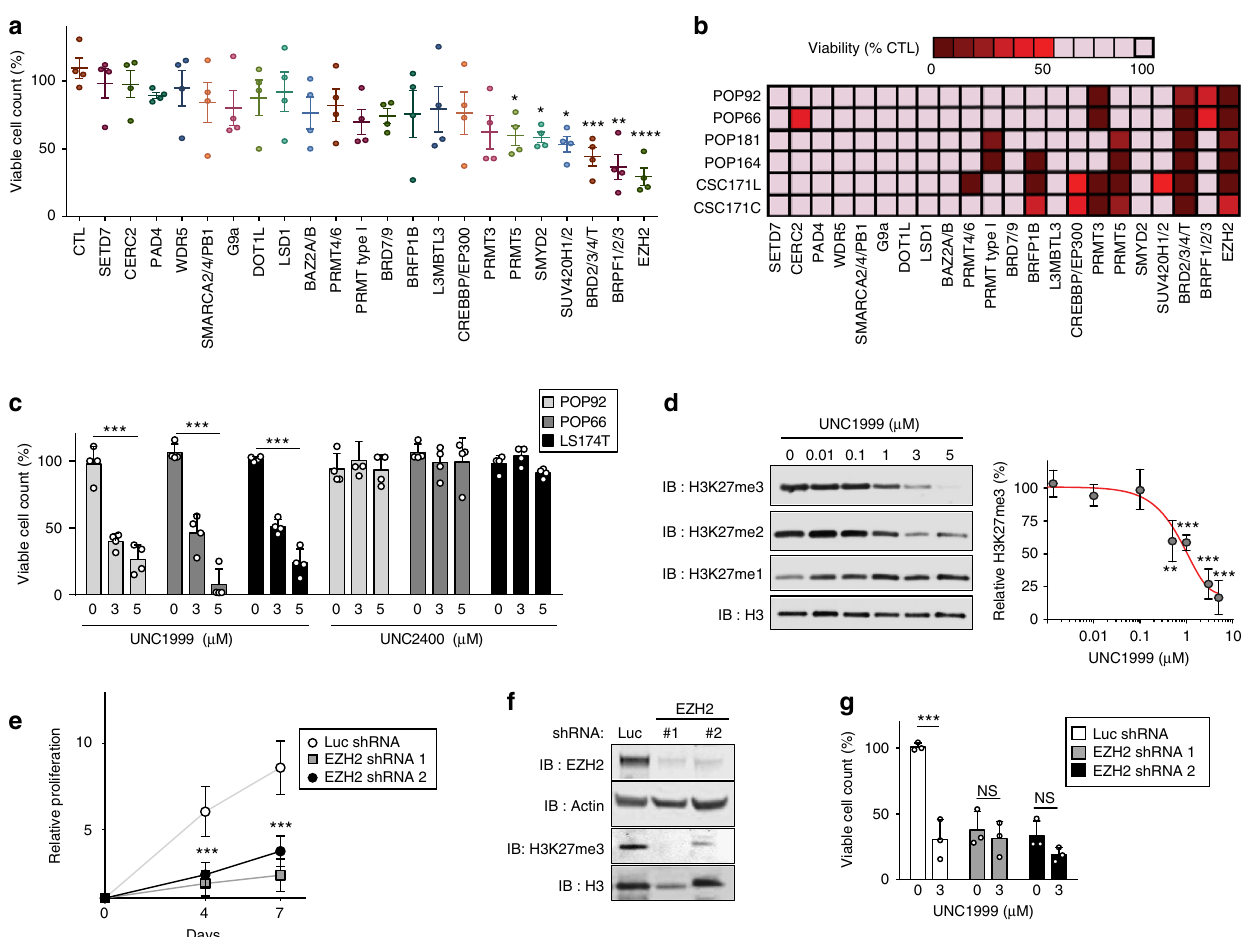
Fig. 1 EZH2 inhibition suppresses growth in patient-derived 3D colon cancer models. a Viable cell count of a patient-derived spheroidal culture, POP92, treated with chemical probes for the indicated epigenetic targets for 7 days. Data shown are mean calculated as percentage of DMSO control ( n = 4, ± SEM, one-way ANOVA). b Epigenetic screen performed on six patient-derived organoid models. Data are represented as percentage of DMSO control. c Two patient-derived (POP92 and POP66) and one commercial cell line (LS174T) grown in spheroid CC-IC enriching cultures were treated with UNC1999 (left) and its negative control UNC2400 (right) for 7 days, and viable cell count was measured and normalised to control. Data shown are mean ( n = 4, ± SD, two-way ANOVA). d Representative western blot showing the decrease of H3K27me3 and H3K27me2 levels in POP92 after 7 days of treatment with increasing concentrations of UNC1999. Quanti fi cation represents the percentage of H3K27me3 levels relative to those of total H3 determined and compared to DMSO control, ( n = 4, ± SD, Student ’ s t test). e Proliferation of POP92 spheroids after EZH2 knockdown using two different shRNAs, or Luciferase shRNA control, monitored by Alamarblue. Data shown are mean ( n = 4, ± SD, two-tailed t test). f Representative western blot showing the knockdown of EZH2 in the samples assessed for proliferation in ( e ). g EZH2 knockdown cells or shRNA luciferase control cells were treated with UNC1999 to show no further reduction in cell growth using viable cell count as readout. Data shown are mean ( n = 3, ± SD, two-way ANOVA). * P < 0.05, ** P < 0.01, *** P < 0.001, **** P < 0.0001. Source data are provided as a Source Data fi